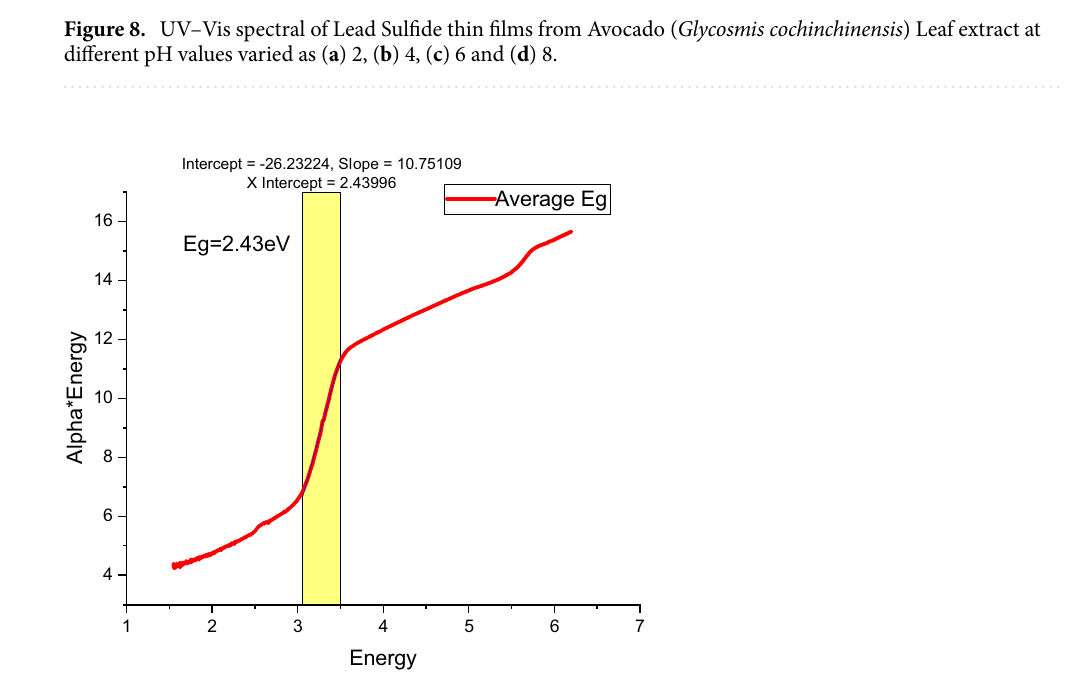
Figure 9. Average energy band-gap of Lead Sulfide film calculated by Tau